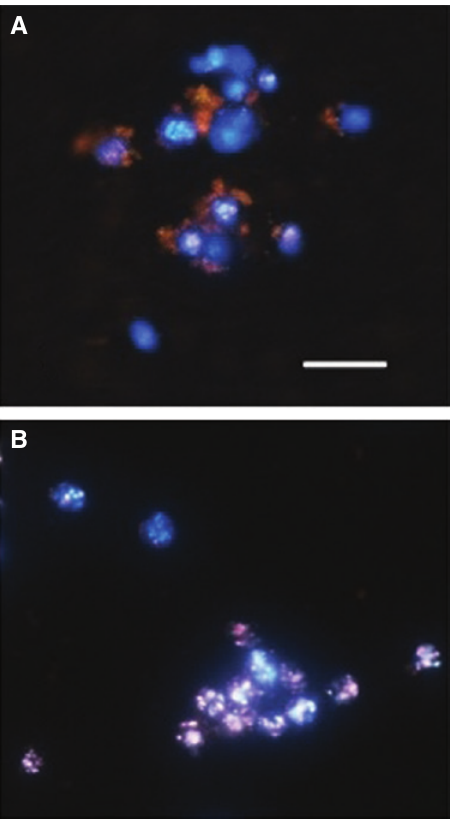
Figure 6: Auto-fluorescent vacuoles and phagosomes in growth phase cells after phagocytosis of fluorescent bacteria (BioParticles). (A) Photographs showing orange fluorescent phagosomes generated by phagocytosis and blue auto-fluorescent vacuoles as independent moieties in cells incubated for 1 h with BioParticles. (B) Photographs showing fluorescent vacuoles with both blue and orange color (auto- fluorescent vacuoles fused with orange fluorescent phagosomes) in cells after another 2 h of incubation. Scale bar = 20 μ